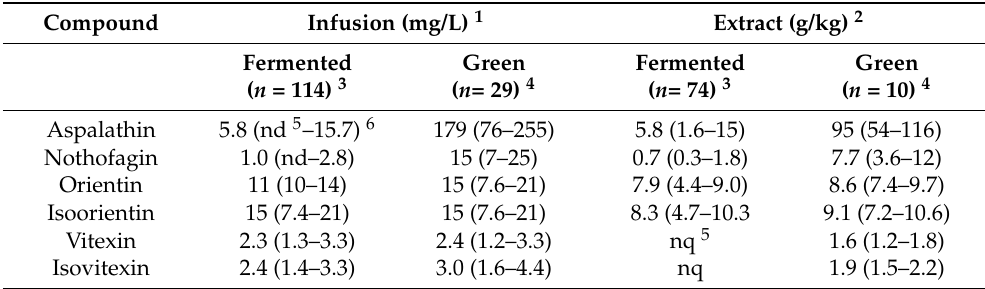
Table 1. Mean individual flavonoid content of infusions and extracts of fermented and green rooibos with the range in